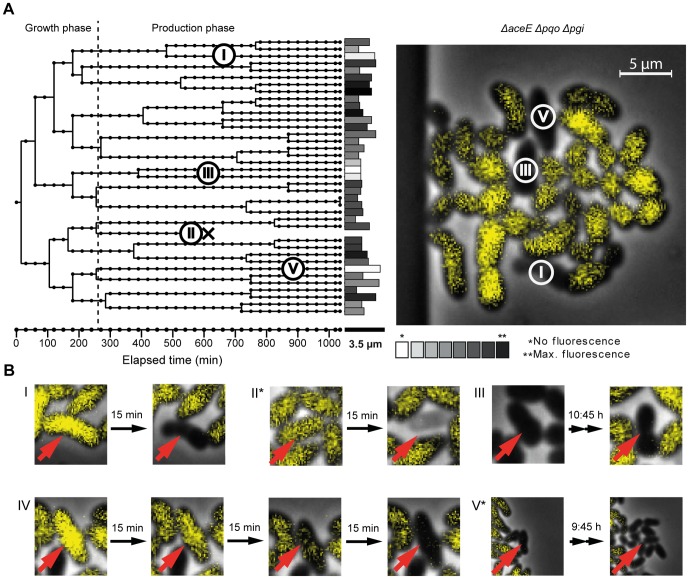
Occurrence of non-fluorescent cells during the production phase.(A) Microcolony and lineage tree of the ΔaceE Δpqo Δpgi sensor strain. Different types of non-fluorescent cells are illustrated in B. (B) (I+II) Lysing cells and (III) dormant/or dead cell, which do not switch from growth to production. (IV) Leaky cell that shows decreasing fluorescence signal over time, potentially caused by a permeabilized cell membrane. (V*) Cells showing slow growth, but no production. Images marked with an asterisk show cells of another microcolony of the ΔaceE Δpqo Δpgi sensor strain, not shown in this figure.